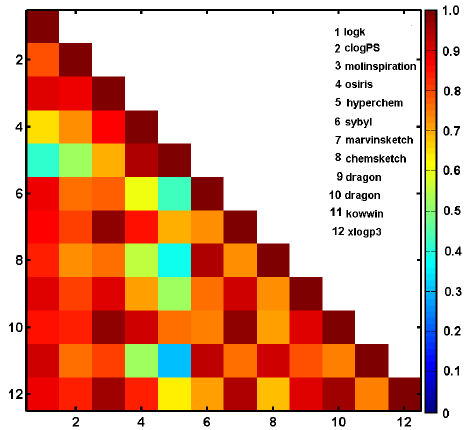
Figure 3. Matrix of correlation coefficients of linear relationships between experimental lipophilicity (log k ) and lipophilicity calculated using different programs.